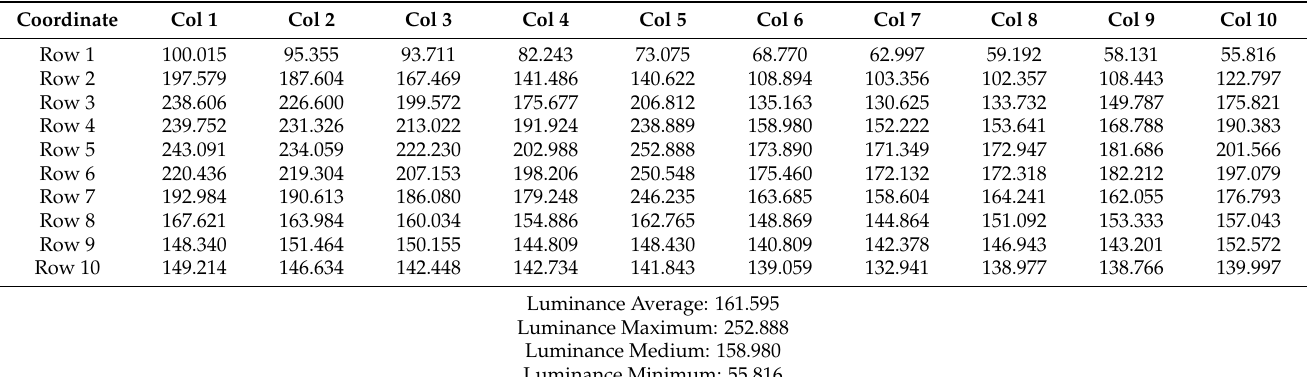
Table 1. The statistical results of the image luminance meter calculating the luminance level.